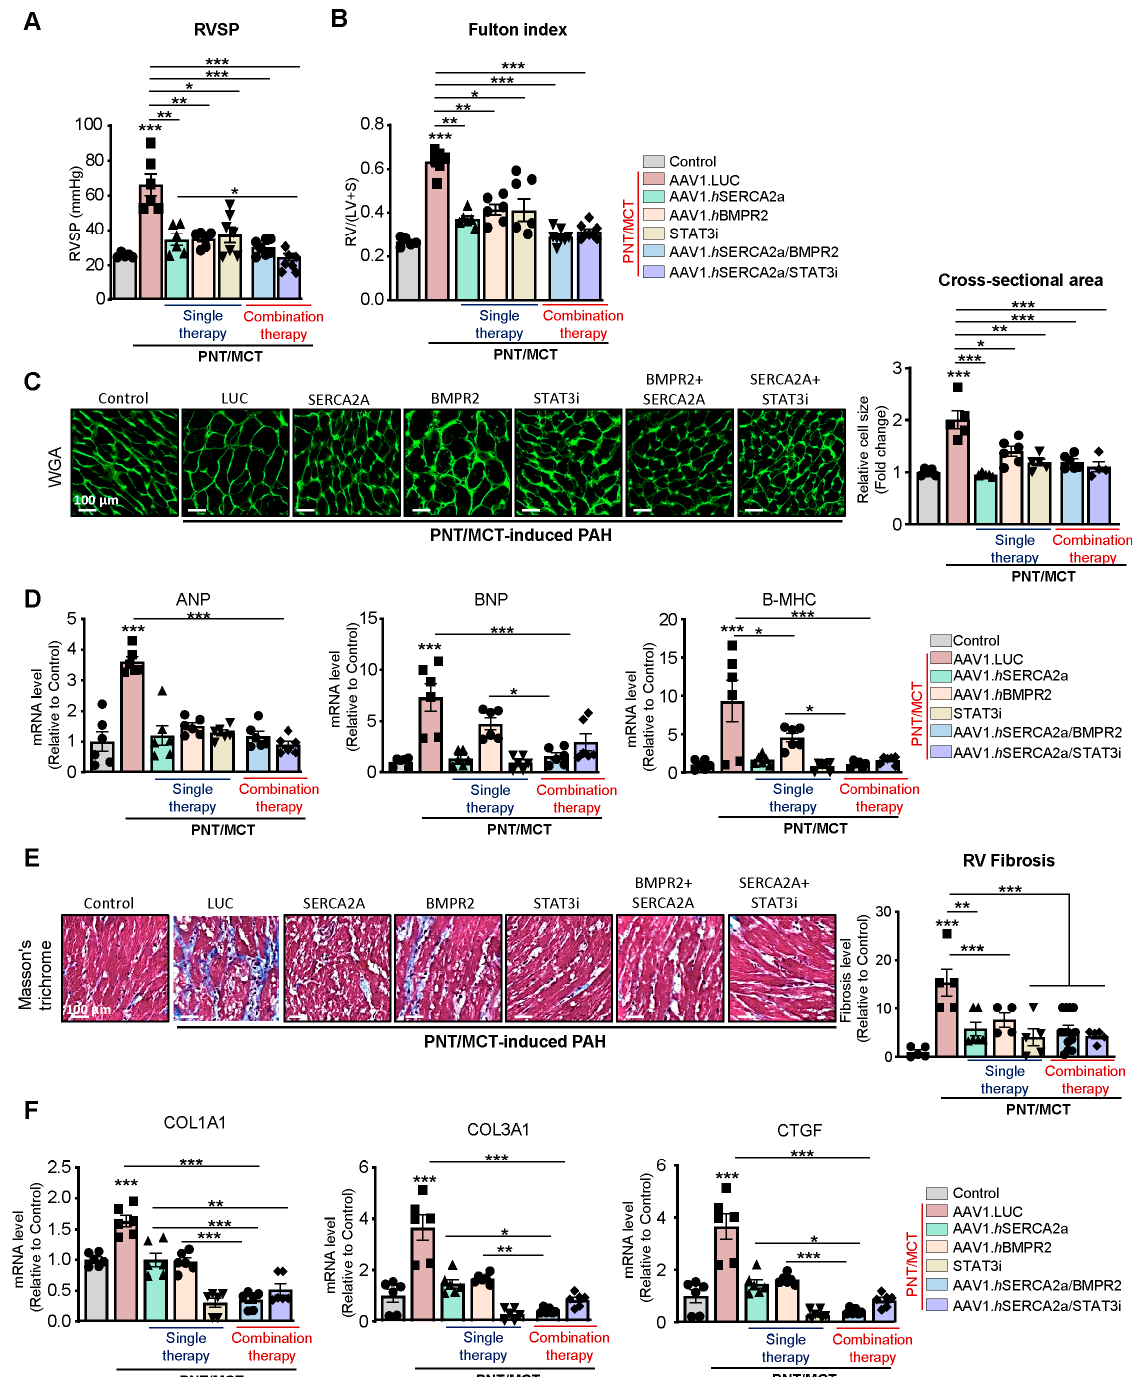
Figure 7. Effects of the combination therapy on RVSP and RV remodeling. ( A , B ). Right ventricular systolic pressure (RVSP) ( A ) and Fulton index (RV/(LV + S)) ( B ) were assessed in control sham rats and PNT/MCT-rats treated with either AAV1.LUC (control, LUC), AAV1. h SERCA2a, AAV1. h BMPR2, or STAT3i alone or in combination as follows: AAV1. h SERCA2a/BMPR2 or AAV1. h SERCA2a/STAT3i, n = 5–7. ( C ) RV sections were stained with fluorescence-tagged wheat germ agglutinin to examine the RV cardiomyocyte cross-sectional area (left). The bar graph represents the quantification of cardiomyocyte size, n = 4–6. Scale bar = 100 µ m. ( D ) Cardiac hypertrophy-related transcript expression levels (ANP, BNP, β -MHC) in the indicated groups assessed by RT-qPCR, n = 6. ( E ) Representative Masson’s trichrome stained heart sections (left). The bar graph represents fibrosis quantification, n = 6. Scale bar = 100 µ m. ( F ) Fibrosis-related transcript expression levels (COL1A1, COL3A1, CTGF) in the indicated groups assessed by RT-qPCR, n = 6. Data are presented as mean ± SEM; * p < 0.05, ** p < 0.01, *** p <